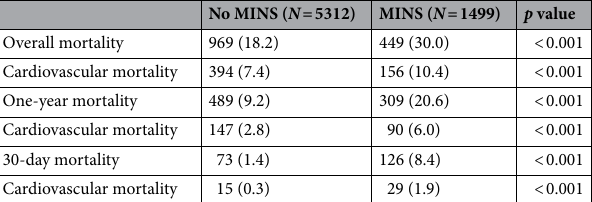
Table 2. Mortalities according to myocardial injury after non-cardiac surgery (MINS). Data are presented as n